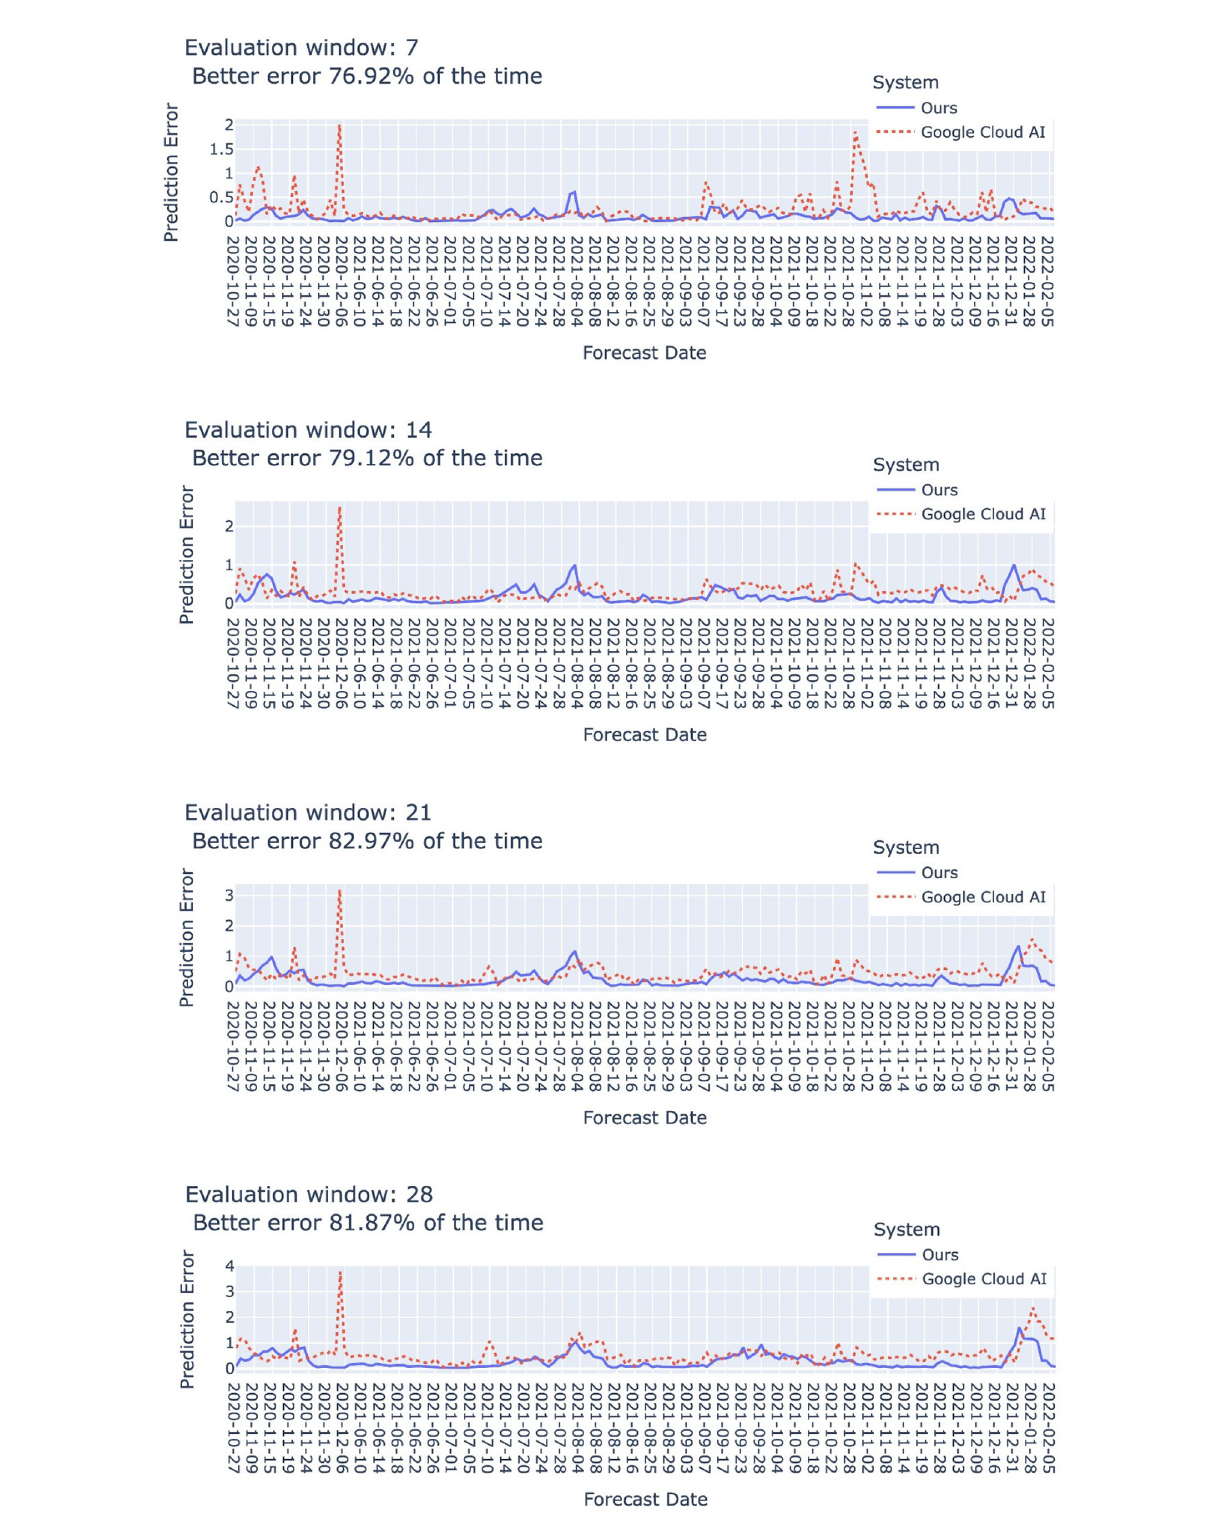
FIGURE7 Comparison with Google Cloud AI (32). The “forecast date” indicates the date when each system is executed to produce the predicted number of cases for the next 7, 14, 21, and 28 days. All the periods indicated by the forecast dates are taken from the “COVID-19 Public Forecasts” dataset by Google Cloud AI. Our system achieved better error in 76.92–81.87% of the time. Dynamic ensemble parameters : τ 1 = 1, τ 2 = 7, m = 10, ˆ δ =